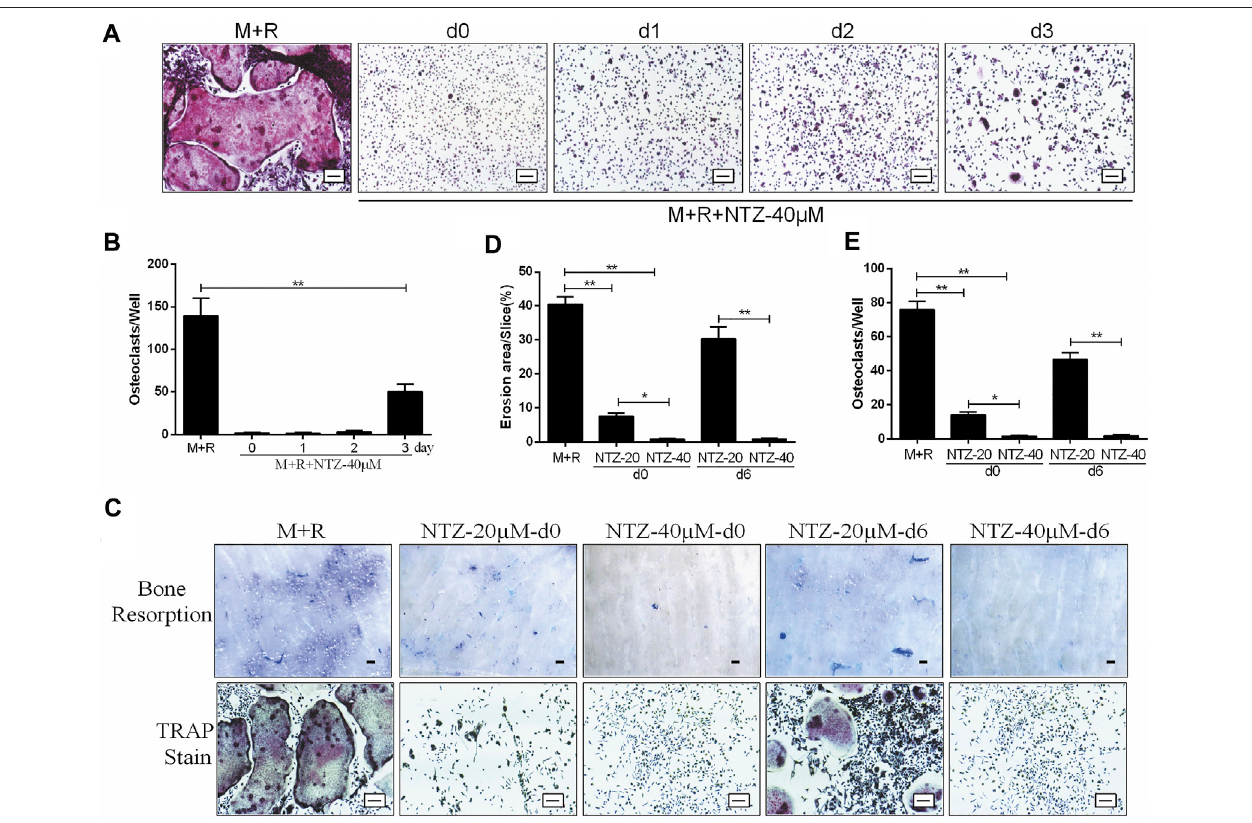
FIGURE 2 | Nitazoxanide inhibited osteoclasts differentiation at an early stage and attenuated osteoclastic bone resorption in vitro . (A) BMMs were induced to generateosteoclastsinthepresenceofM-CSF(10 ng/ml)andRANKL(50 ng/ml)for7 days.NTZ(40 µM)wasaddedtothemediumattheindicatedtimes(days0,1,2, or 3). On the day 7, TRAP staining wasperformed. Scale bar (cid:2) 100 µm. (B) TRAP staining positive multinucleate cells were counted. (C) BMMs were seeded onto bone slices in a 48 well plate and treated with M-CSF (10 ng/ml) and RANKL (50 ng/ml), and NTZ (20 or 40 µM) was added at d0 or d6 of the assay for 14 days. Resorption lacuna was stained with toluidine blue (top) . Scale bar (cid:2) 250 µm. The cells around the bone slices were used for TRAP staining (bottom) . Scale bar (cid:2) 100 µm. (D – E) The resorption pit areas and number of osteoclasts were quanti fi ed. Error bars represent mean ± SD from three independent experiments. d (cid:2) day; M (cid:2) M-CSF; NTZ (cid:2) nitazoxanide; R (cid:2) RANKL. * p value ＜ 0.05, ** p value ＜